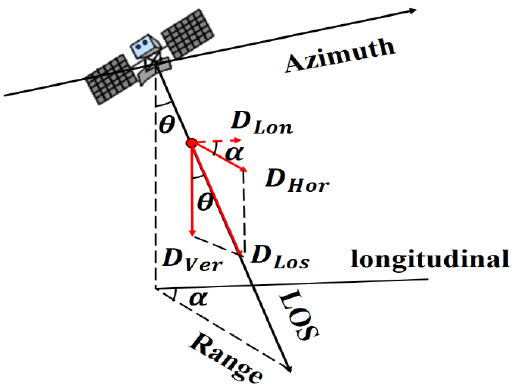
Figure 2. Scheme of displacement detection in Synthetic Aperture Radar (SAR) geometry.